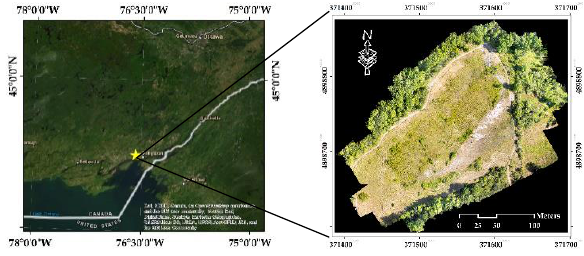
Figure 3. The location of the study area and its UAV mosaicked sample